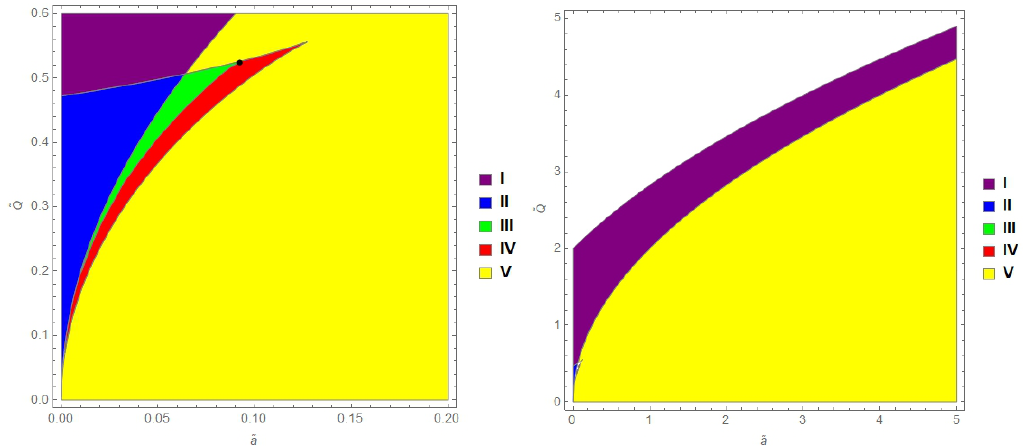
Figure 1. The (cid:12)ve regions in the ~ a - ~ Q phase space of a BI black hole (BH) in a cavity, each of which possesses distinct behavior of the phase structure and transition. Varying the temperature, a van der Waals-like LBH/SBH phase transition occurs in Regions II and III while a Hawking-Page-like ES/BH phase transition occurs in Regions III, IV and V. There is only one phase in Regions I. The critical line consists of ~ Q 12 (~ a ) and ~ Q 35 (~ a ), where ~ Q ij (~ a ) is the boundary between Region